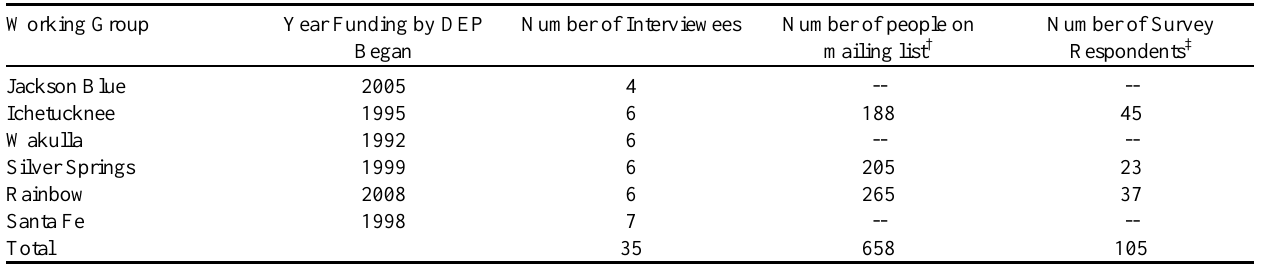
Table 1 . Springs Basin Working Groups (SBWG) managed by Florida Department of Environmental Protection